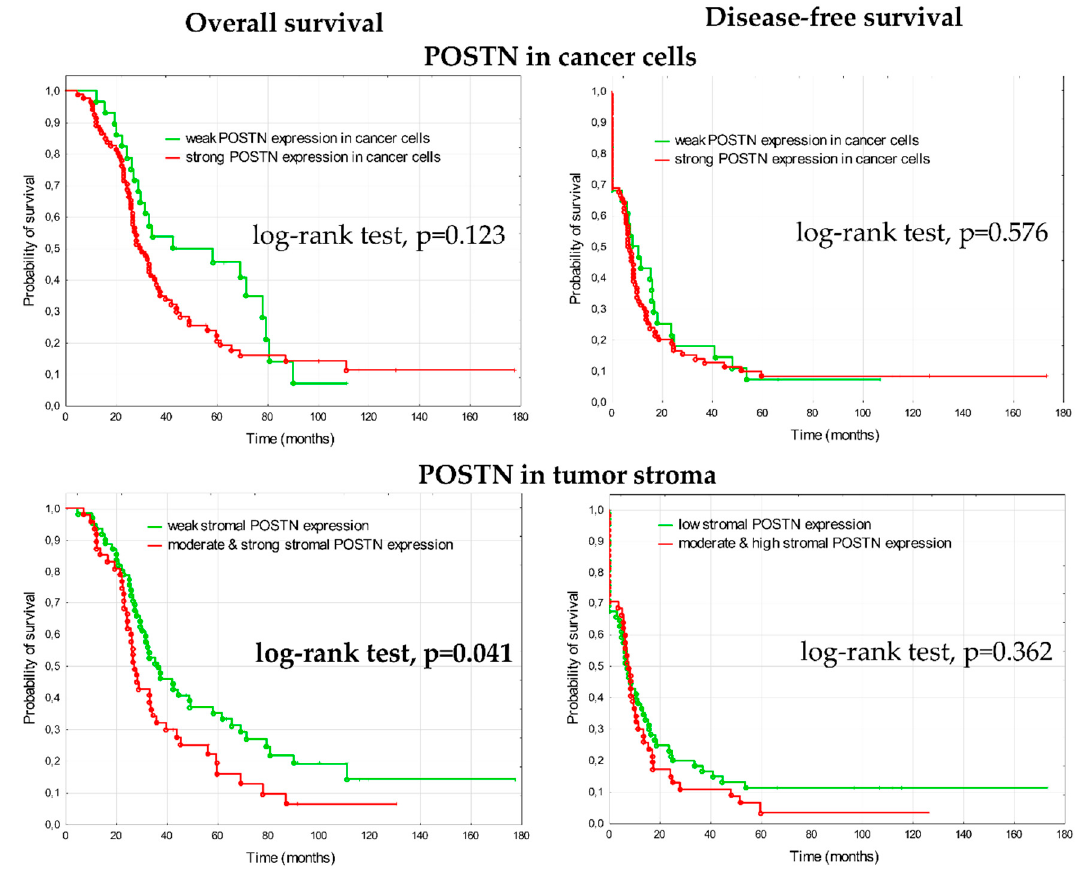
Figure 7. Kaplan–Meier analysis of overall survival (OS) and disease-free survival (DFS) in 108 patients with advanced ovarian cancer stratified by weak versus strong periostin expression in cancer cells and weak (score 1) versus higher (score 2 + 3) periostin expression in the tumor stroma.